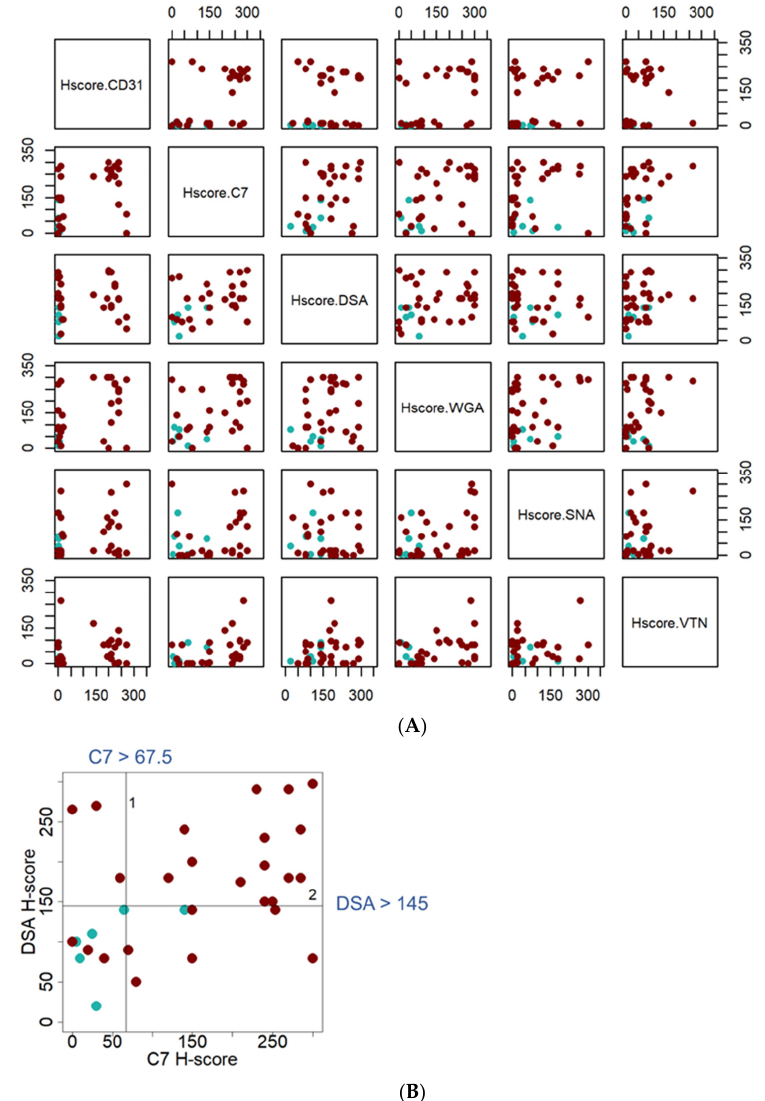
Figure 5. Scatter plots of H-scores distribution, assessed from lectin-immunohistochemical labelling for complement C7 and VTN as well as DSA, WGA, and SNA. ( A ) Matrix scatter plots created for the candidate antibodies/lectins H-scores. The darker dots (dark brown) represent H-score assessed from the cancer component of HSA splenic tissue samples, while the lighter dots (light green) represent H-score assessed from the HSA-like lesion of non-HSA (hematoma and hemorrhage) splenic tissue samples. ( B ) Scatter plot of H-scores distribution assessed from lectin-immunohistochemical labelling with the anti-human complement C7 antibody and DSA lectin. The pair of reactants was selected from recursive partitioning results. Two cut-off points, complement C7 (H-score > 67.5) then DSA (H-score > 145), allow clear distinction between HSA and HSA-like tissues.